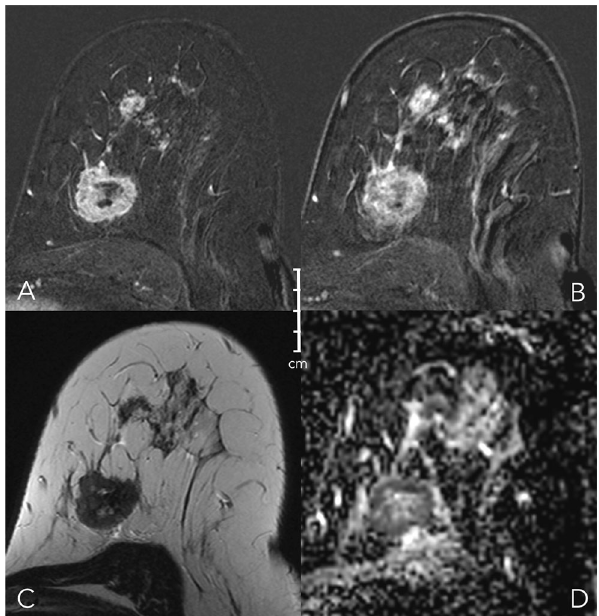
Fig. 12 Early (A) and delayed (B) contrast-enhanced subtractions, T2w (C), and ADC map (D). Mass and non-mass lesions in the left breast of a 48-year-old female undergoing MRI for staging purposes because of conventional BI-RADS 5 findings prior to biopsy. The main mass lesion shows multiple subtle spiculations, a wash-out curve type, and a perifocal oedema, corresponding to a Kaiser score of 11 (Fig. 6). Note central necrosis (high signal in C) and low ADC (0.7*10 -3 mm 2 /s). The anterior lesions show no spiculations, a plateau curve type, and irregular margins, corresponding to a Kaiser score of 5 (Fig. 6). Again, ADC is low (0.9-1*10 -3 mm 2 /s). Histopathology revealed a multicentric IDC, G3, with a DCIS component,